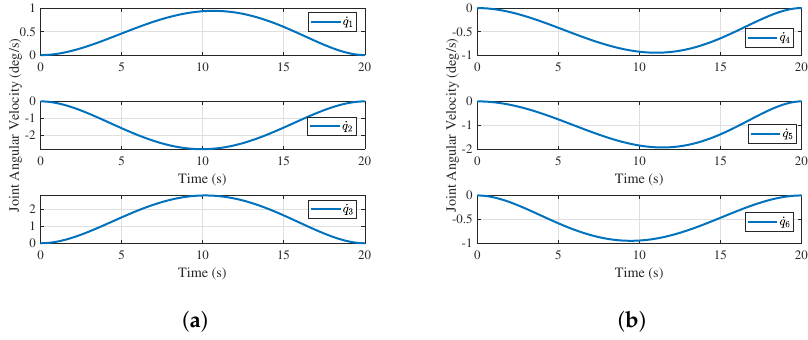
Figure 8. Velocity variation curves of i th joint, where ( a ) i = 1, 2, 3, and ( b ) i = 4, 5,